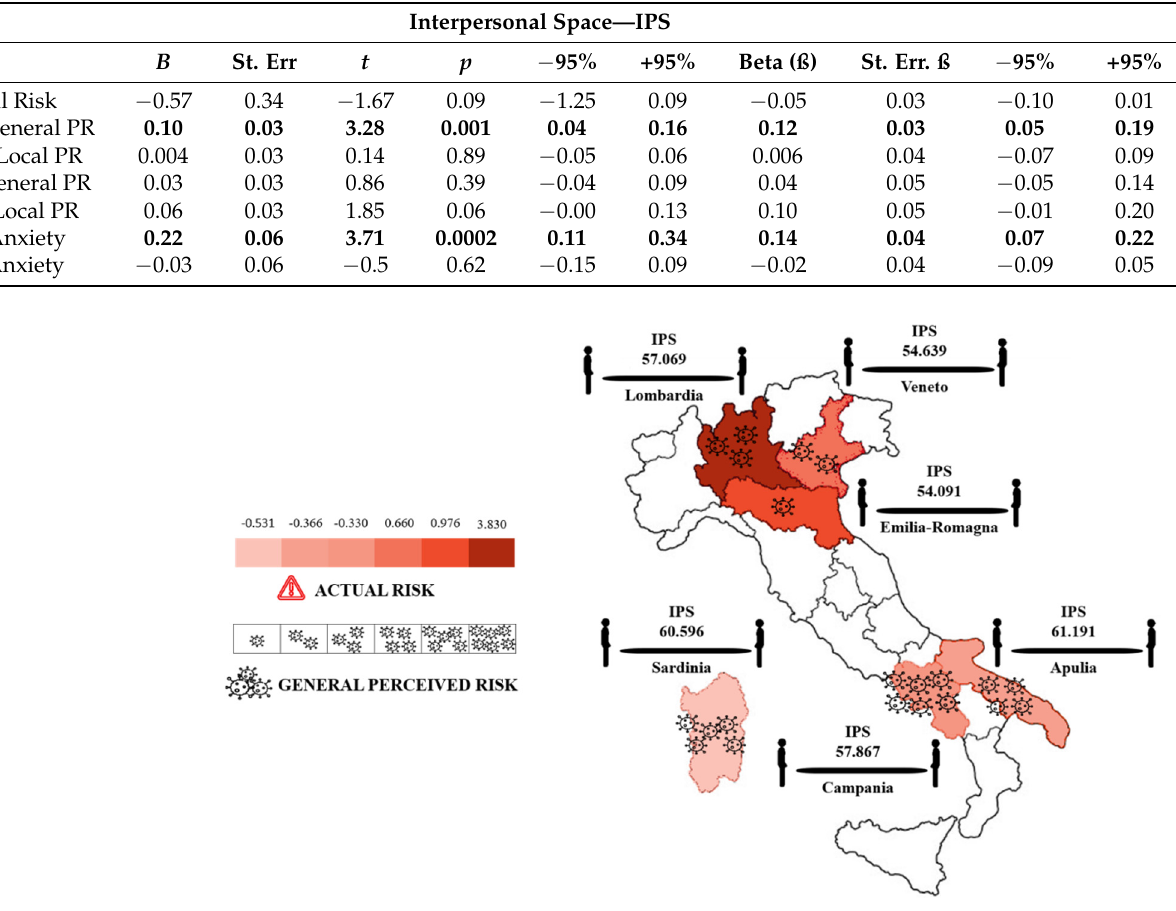
Table 2. The table shows the effect of actual and perceived risk (PR) and state and trait anxiety on IPS. B coefficients, standard errors, t and significance levels for predictors of the outcome variable, standardized beta coefficients and 95% CIs are reported.